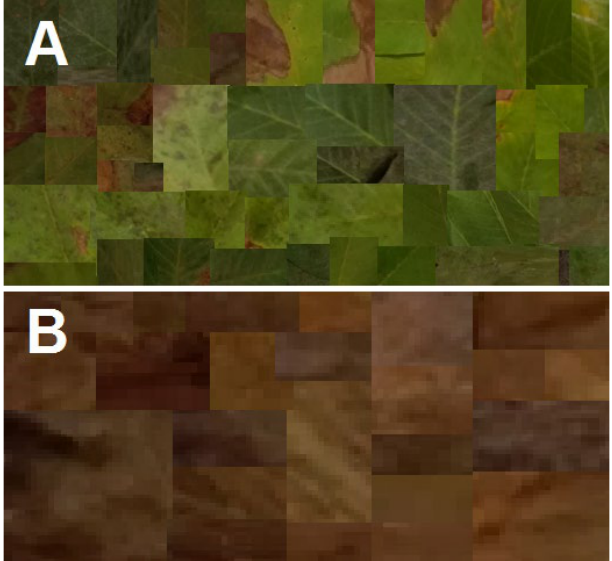
Figure 1. The collage arrangement of leaves samples (A) and infected regions (B) used to generate a color threshold for image